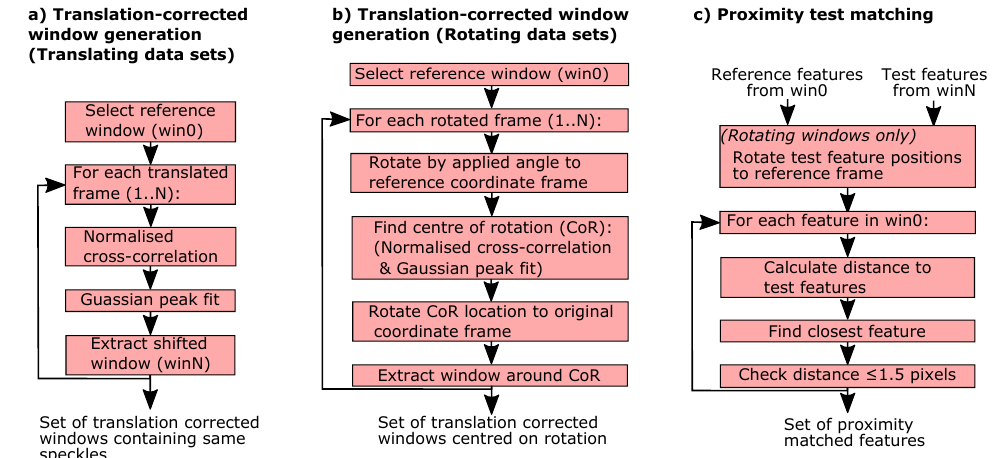
Figure 6. Flow diagrams showing the analytical methods used to investigate the performance of feature tracking algorithms. ( a ) The generation of translation correction windows containing common speckles for translating data sets. ( b ) The generation of translation correction windows from rotating data sets. ( c ) The proximity test method of matching speckles between